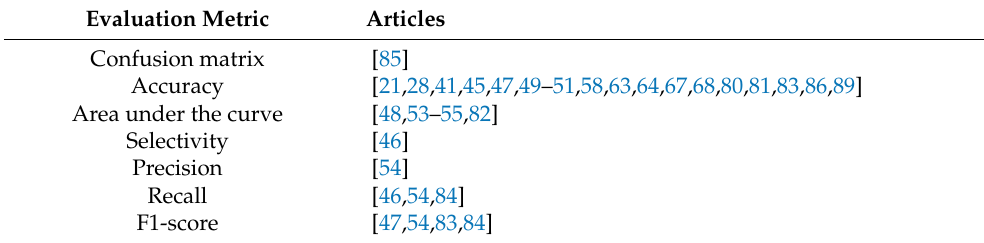
Table 8. Classification evaluation